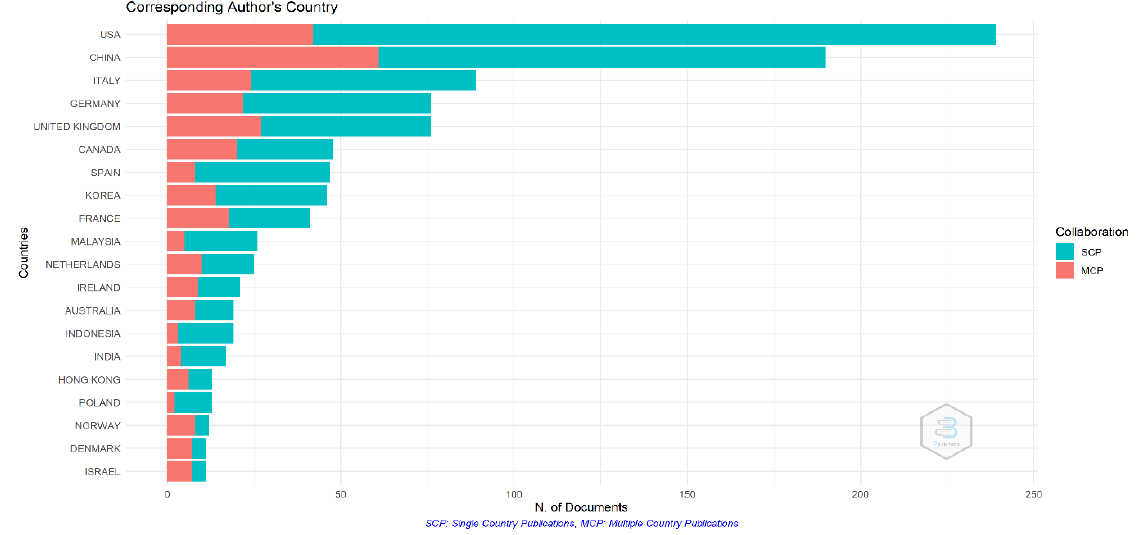
Figure 6. Country collaboration.